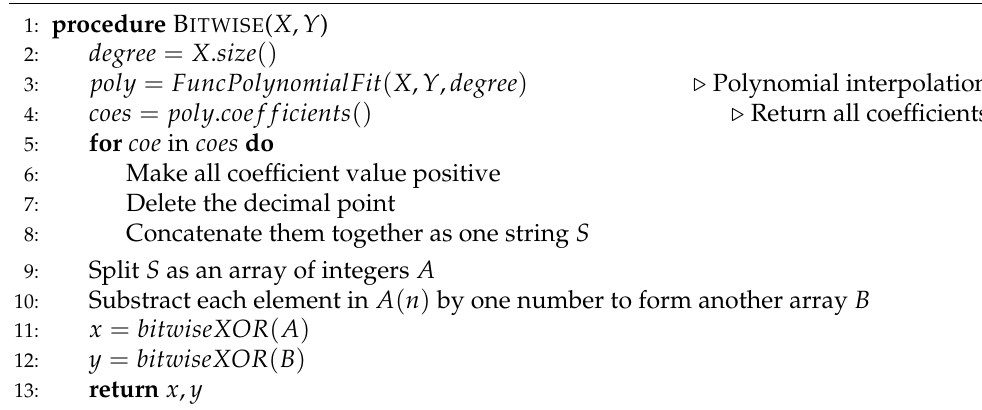
Algorithm 1 Algorithm to generate random data points. The parameters X and Y are the collections of data points such that X contains all x i and Y contains all y i